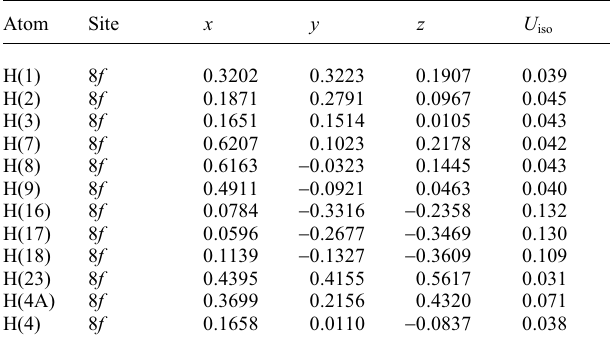
Table 2. Atomic coordinates and displacement parameters (in Å 2 )